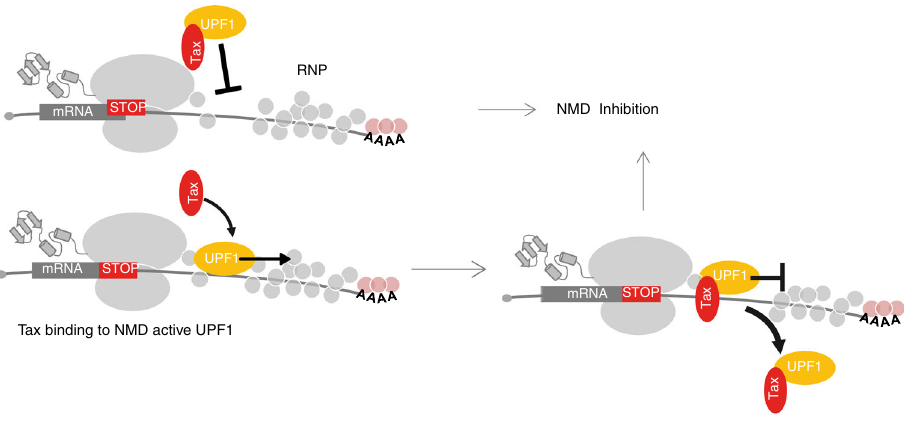
Fig. 6 Model proposed for Tax-mediated inhibition of UPF1 activity. The fate of UPF1 depends on the time frame of interaction with Tax that occurs during HTLV-1 infection. Tax can prevent the recruitment of UPF1 to the RNA substrate. Alternately, Tax can affect the activity of previously bound RNA and NMD-engaged UPF1: the translocation activities of UPF1 can be blocked by Tax binding. The UPF1/Tax complex then dissociates from the RNA substrate or remains stuck in